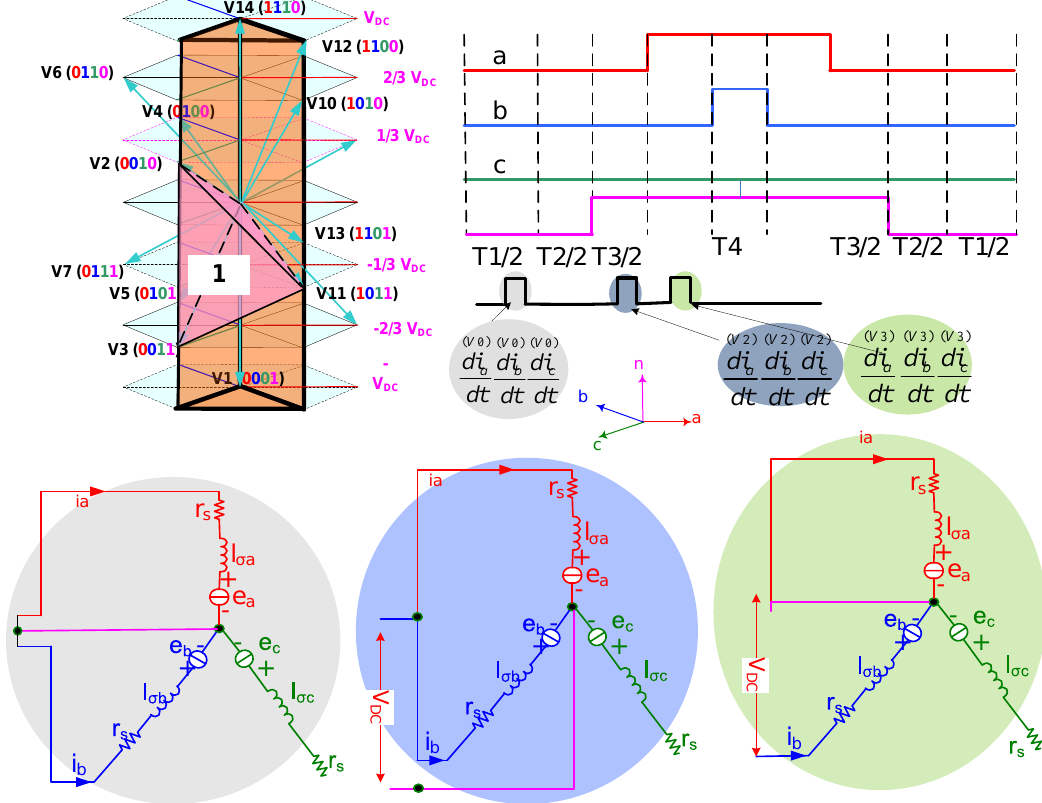
Figure 9. Switching sequence in 3D SVM when the reference voltage exists in prism 5 and tetrahedron 1 and the stator dynamic circuits under application of the voltage vectors V0, V1, and V2 post a loss of phase “c”.